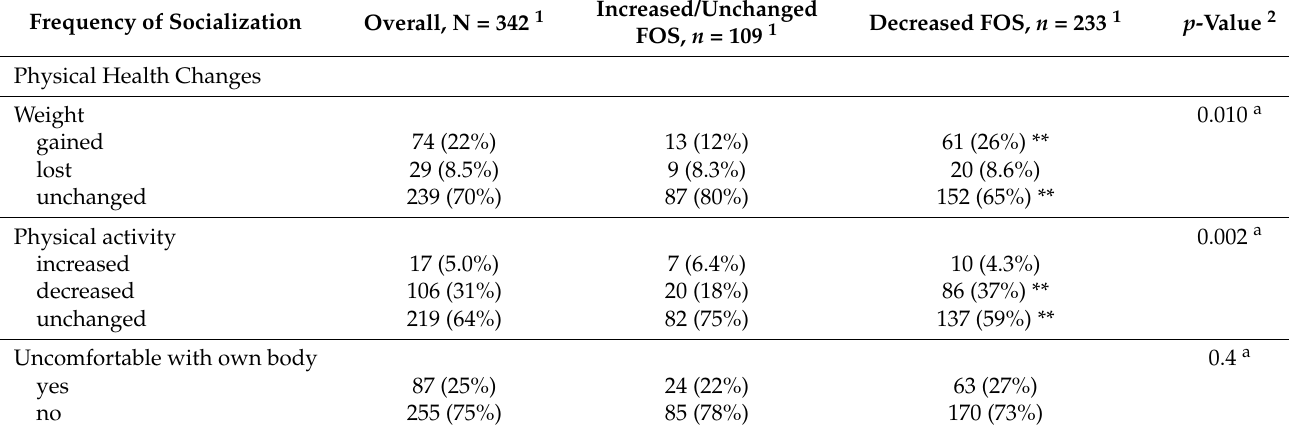
Table 4. Bivariate statistics for physical function changes by frequency of